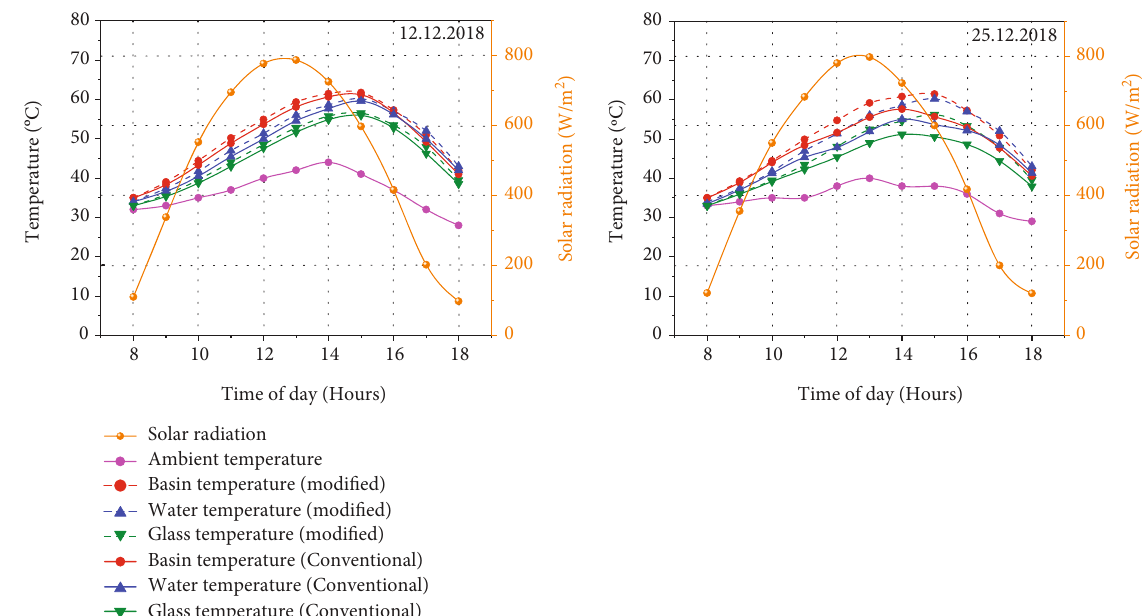
Figure 3: Variations in solar intensity, basin, water, and glass temperature of CBSS and TBSS on 12.12.2018 and 25.12.2018.